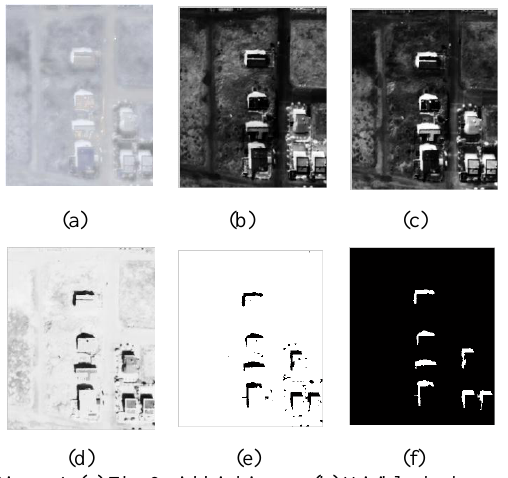
Figure 4. (a) The Quickbird image, (b) Visible shadow candidate map, (c) NIR shadow candidate map, (d) Shadow map, (e) Shadow mask, (f) the final result of the shadow mask after enhancing the current algorithm Figure 5. Multiregion image segmentation framework for shadow detection. Modified after Salah et al.